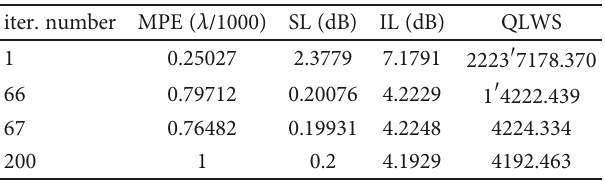
Figure 4: Behaviour of the QLWS cost function for the Rotman lens optimization. Blue line: QLWS cost calculated for each call in the Nelder Mead algorithm. Red line: minimum cost found by the algorithm. The points marked with black circles are detailed in Table 2. Table 2: Behaviour of the Rotman lens parameters for some of the noticeable points of Figure